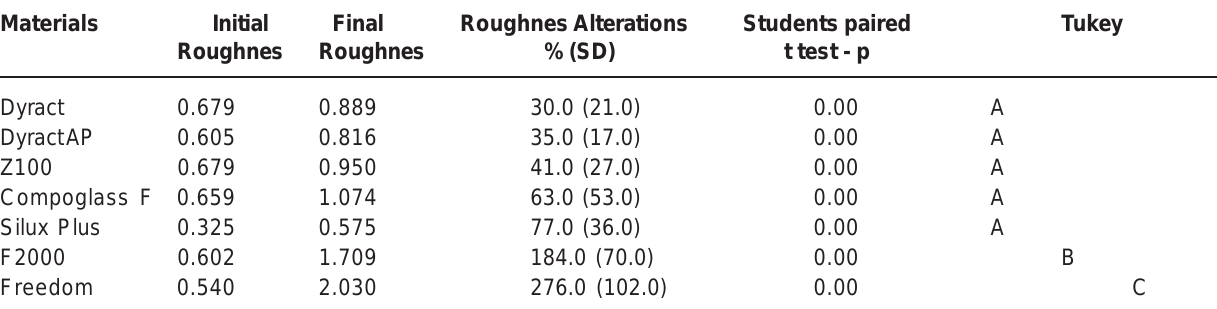
n=12; p<0.05; Different letters indicate statistical differences.